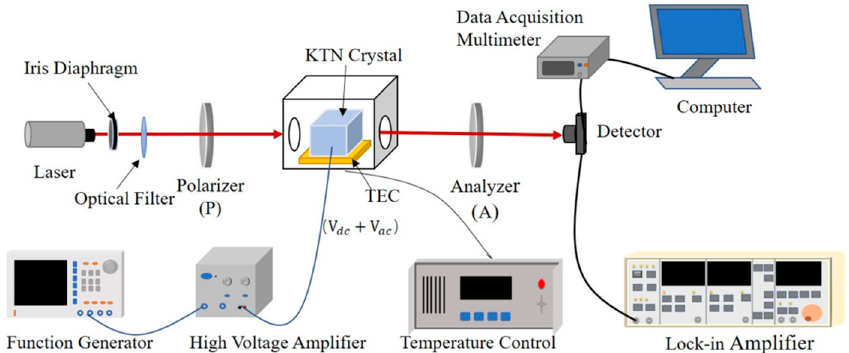
Figure 4. Schematic diagram of the experimental light path.